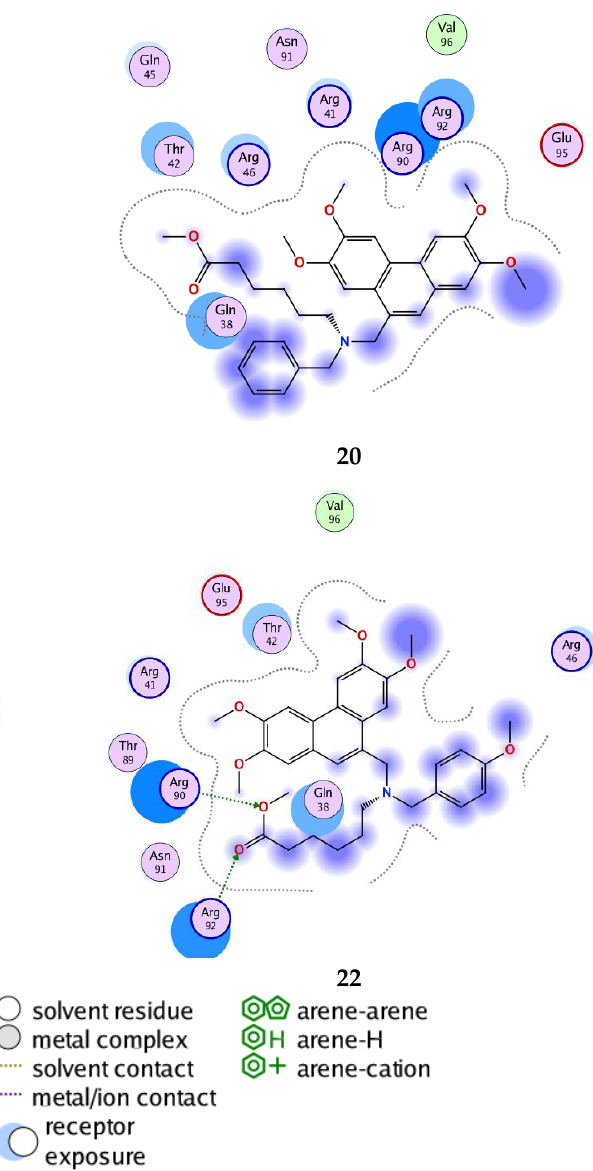
Figure 1. Binding affinity of compounds 1 and 20 − 22 with 2 OM3.